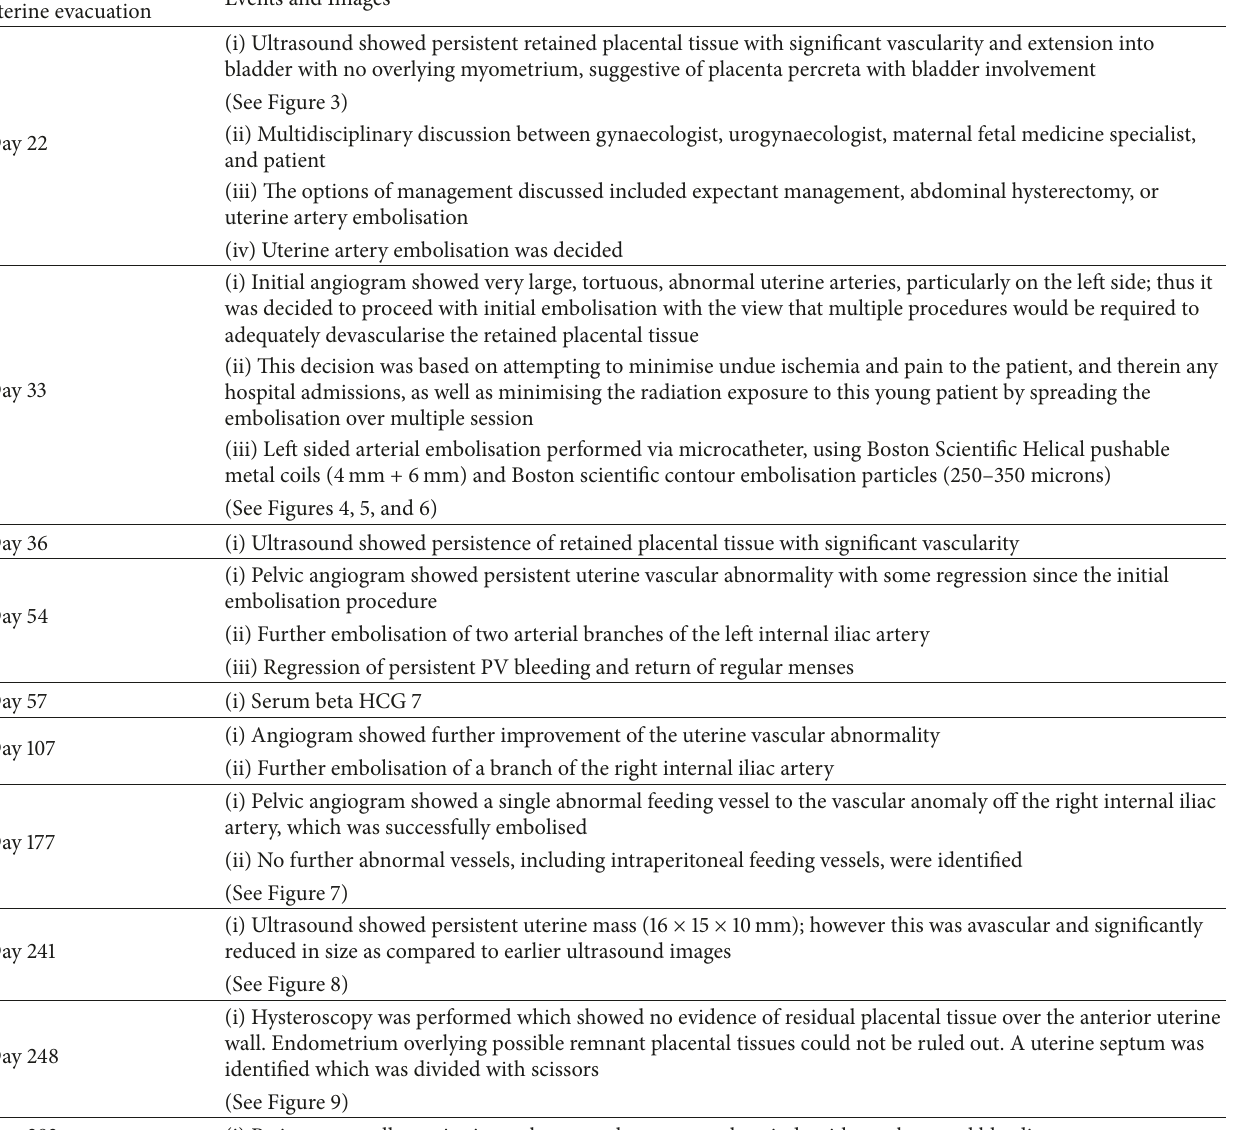
Table 1: A timeline summary of the management of this